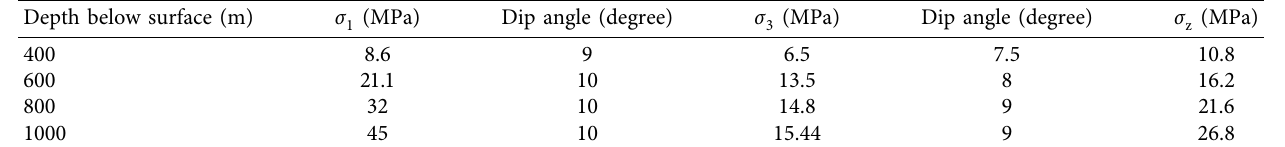
Table 2: The measurement results of in situ stress.